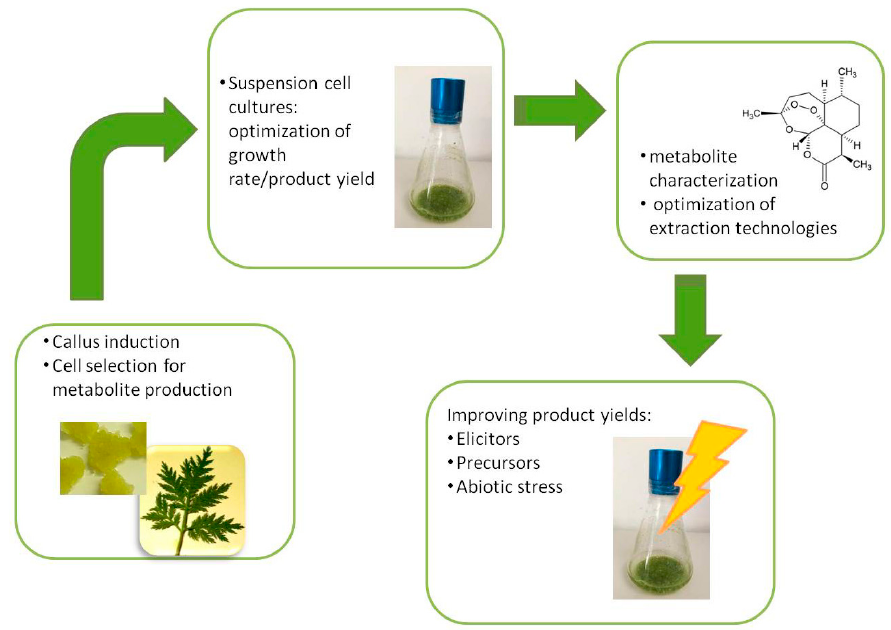
Figure 2. Schematic framework for the production of bioactive compounds by plant cell cultures.